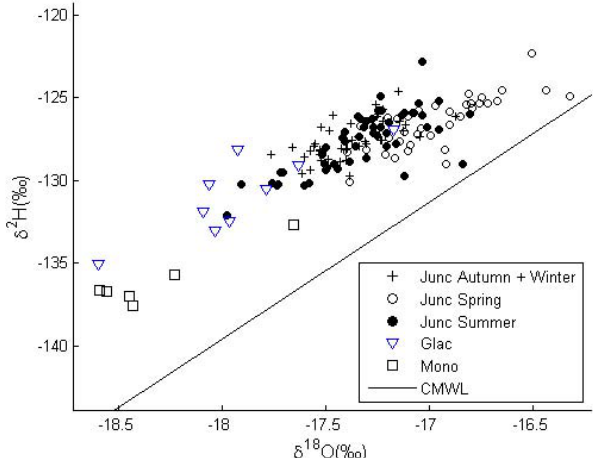
Fig. 8. Isotopic composition of water samples from the Jun- cal River (Junc) and from the glacier (Glac) and Monos de Agua (Mono) tributaries. Junc samples are grouped by season; CMWL is a line representing the δ 18 O/ δ 2 H relationship defined as the Chilean Meteoric Water Line ( δ 2 H = 8.3 · δ 18 O + 9.8; Spangenberg et al.,